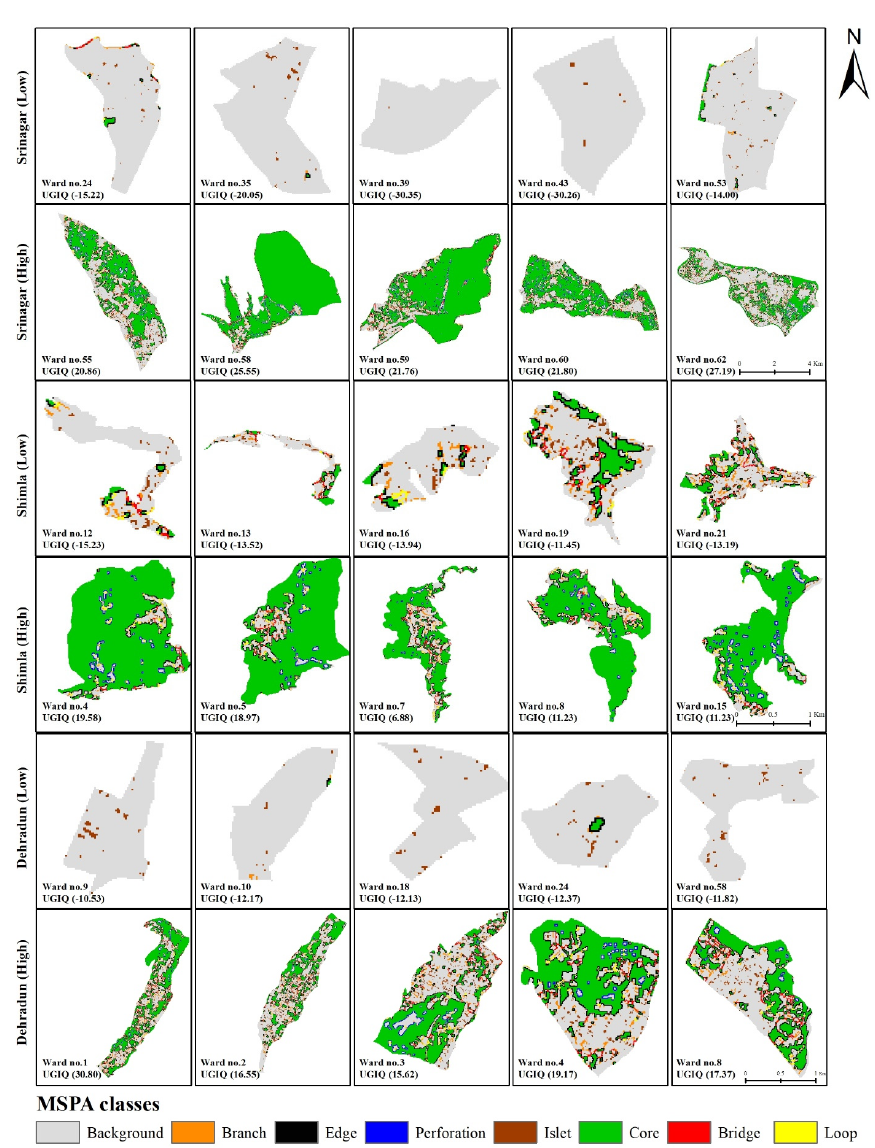
Figure 11. Spatial variation in MSPA classes in selected low and high UGIQ wards of the three